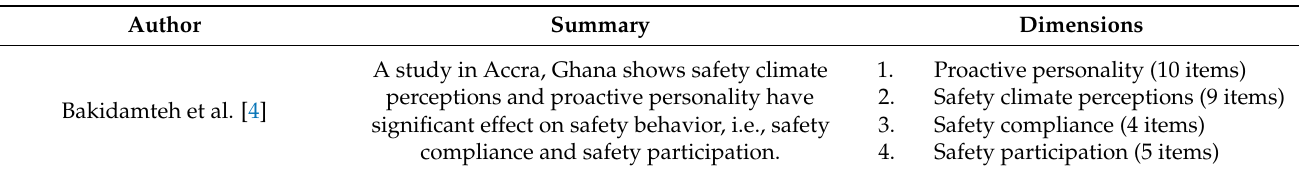
Table 1. Search result on “safety climate” and “fuel